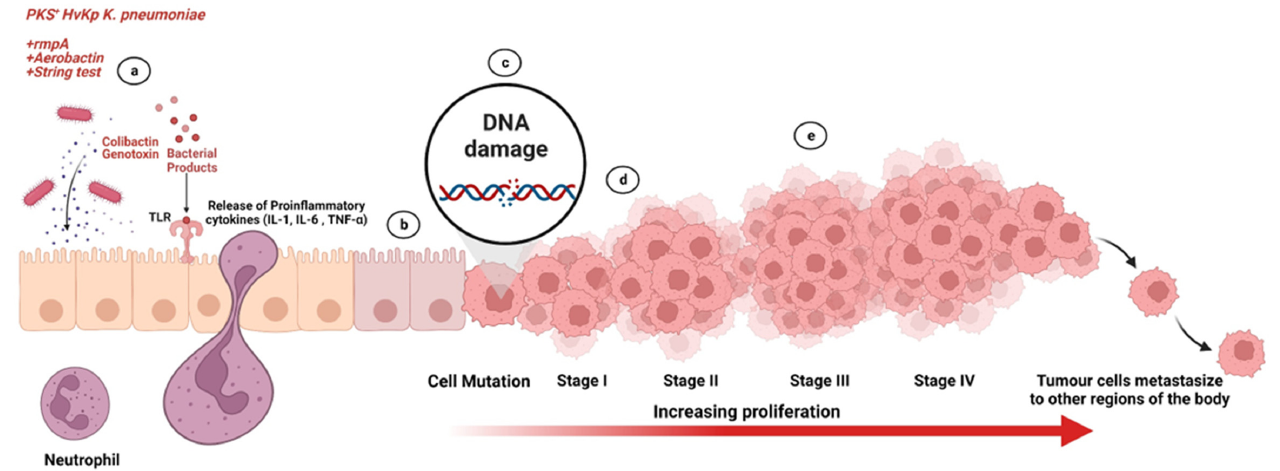
Figure 11. Summary of study depicting action of colibactin genotoxin from HvKp strains on human colonic mucosa. (a) PKS-positive HvKp strains colonizes the host colonic mucosa and exerts damage through the release of colibactin genotoxin. (b) Chronic exposure of colonic mucosa to colibactin genotoxin leads to inflammation of colonic mucosa tissue. (c) Colibactin genotoxin causes DNA double strand breaks in host cells. (d) Mutation occurs in host cells leading in disruption of the genes regulating colonic epithelial cell renewal. (e) Disruption in genes regulating colonic epithelial cell renewal initiates activation and enhancement of tumorigenesis. Illustration created with Biorender.com